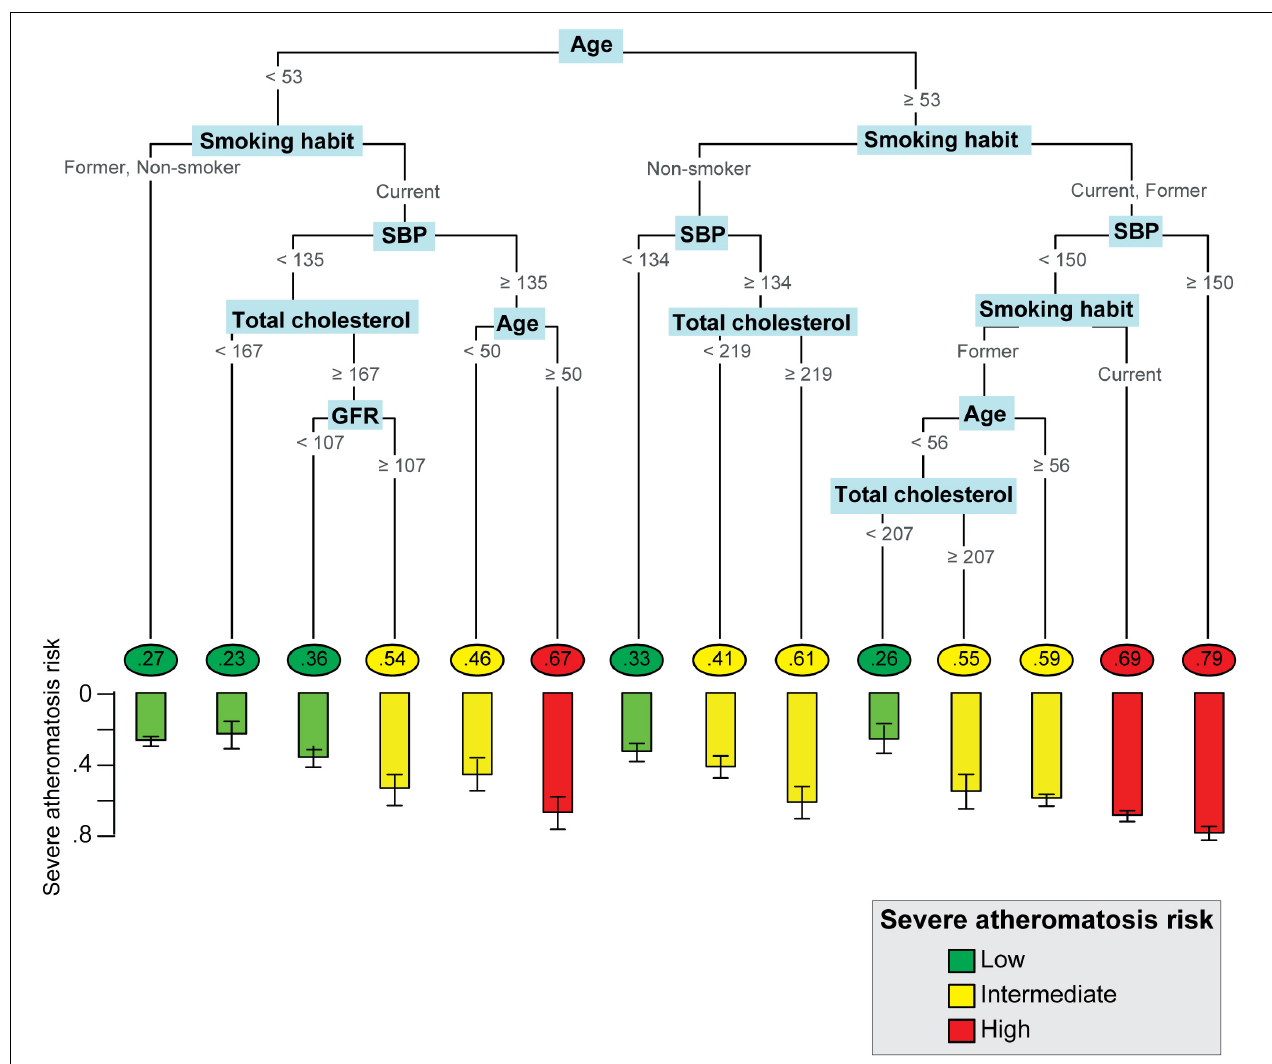
FIGURE 2 | Personalized Algorithm for Severe Atheromatosis Prediction in men. The structure of the classification tree in men is represented. The probability of severe atheromatosis, which corresponds to the proportion of affected patients, is shown inside circles in the final nodes. The barplot offers a clearer visualization of this prevalence with its 95% confidence interval. The colors green, yellow, and red indicate the level of risk (low, intermediate, or high) identified after calibration. The units were as follows: age, year; GFR, ml/min/m 2 ; SBP, mmHg; total cholesterol, mg/dl. GFR, glomerular filtration rate, SBP, systolic blood pressure.